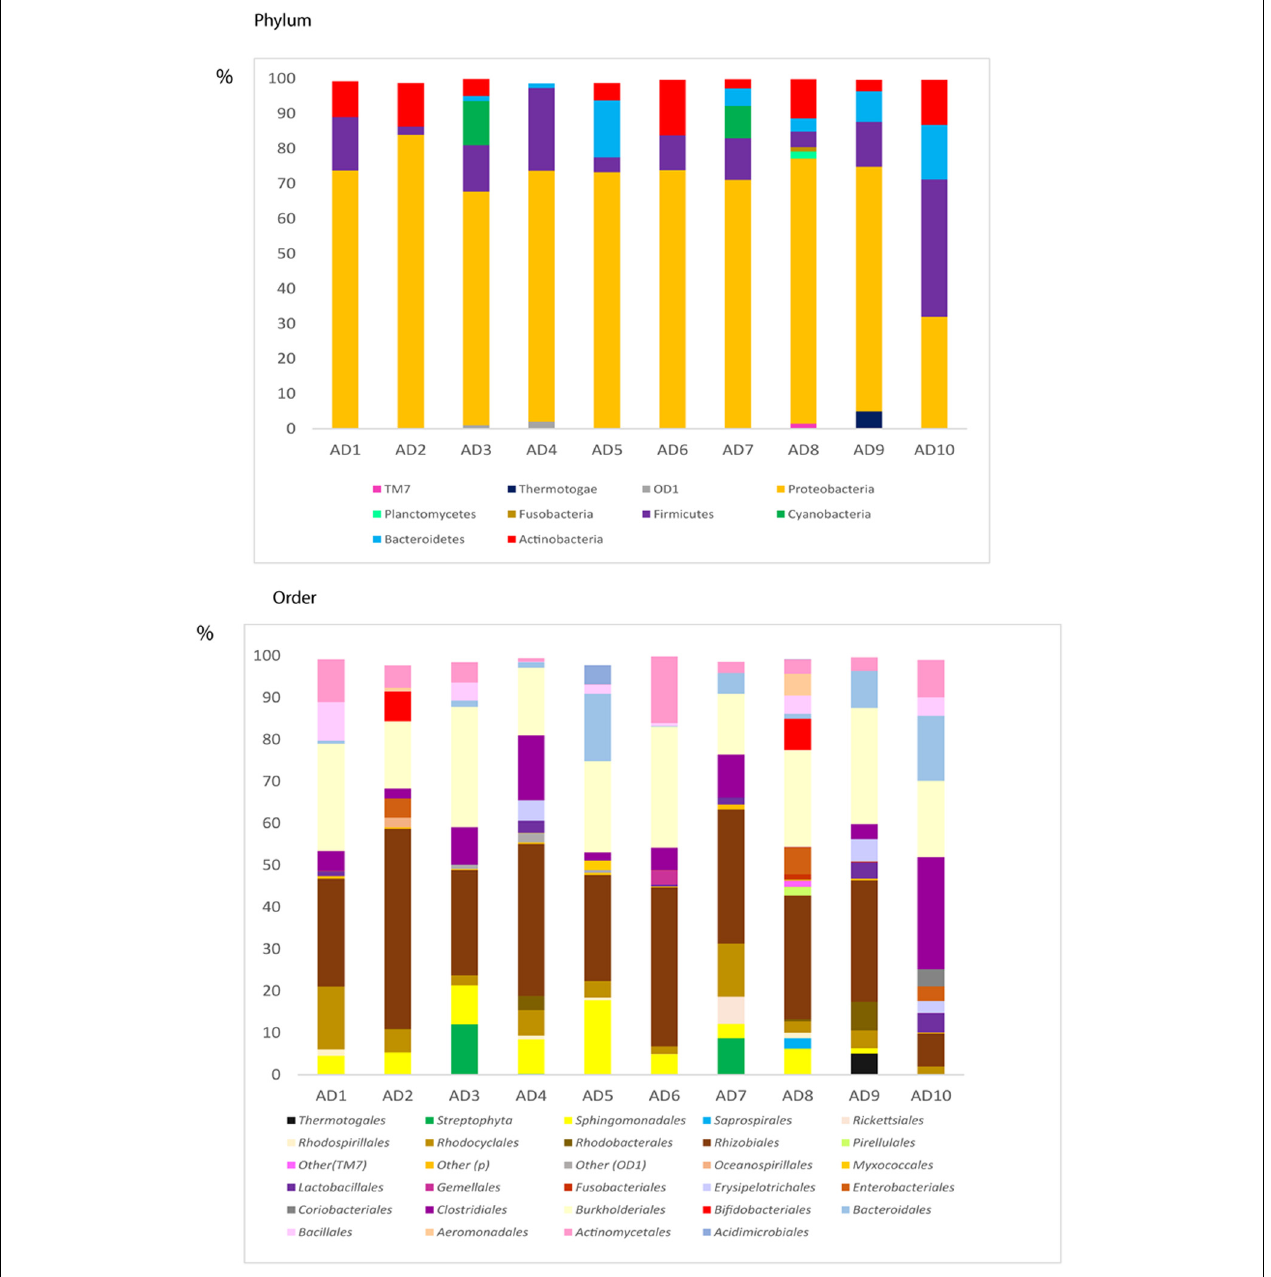
FIGURE 9 | Distribution of bacteria phyla and orders obtained by NGS of DNA from AD patients. Computational analyses of the sequences obtained on the Illumina platform using Qiime classified the data into bacteria phyla and orders. (Upper) Shows the results of bacteria phyla obtained from ERH samples from 10 AD patients. (Lower) Shows the results of bacterial orders obtained from ERH samples from 10 AD patients.